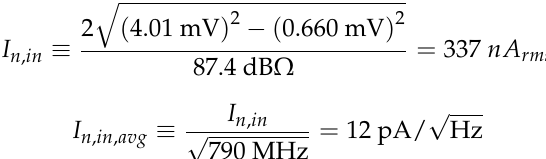
Figure 11. Measured noise output voltage of the proposed Rx IC.